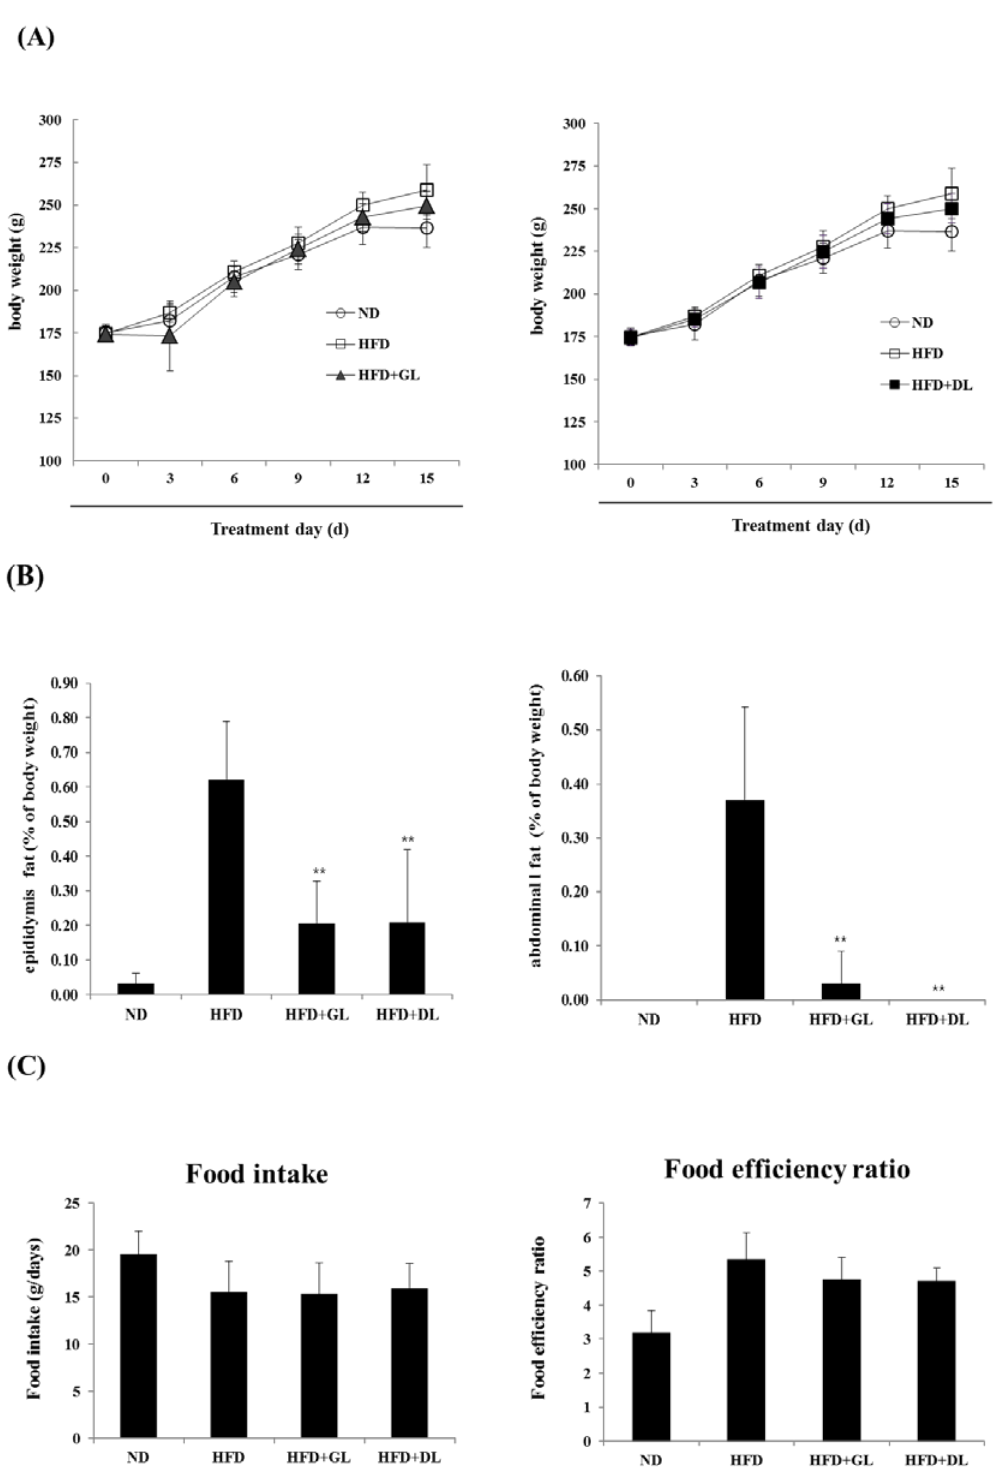
Figure 1. Effects of GL and DL on body weight, adipose tissue mass, and food intake in high-fat diet (HFD)—induced obese rats. The rats ( n = 7 per group) were fed an ND or HFD. Additionally, HFD-fed rats were also treated with GL or DL at a dose of 3.3 mg/kg/day. ( A ) Body weight was measured every three days; ( B ) total epididymal WAT and abdominal WAT weight; and ( C ) food intake and food efficiency ratio. Significantly different from the HFD group, ** p < 0.01 and * p < 0.05. Bar graphs show the mean ± SD from seven individual rats per group.